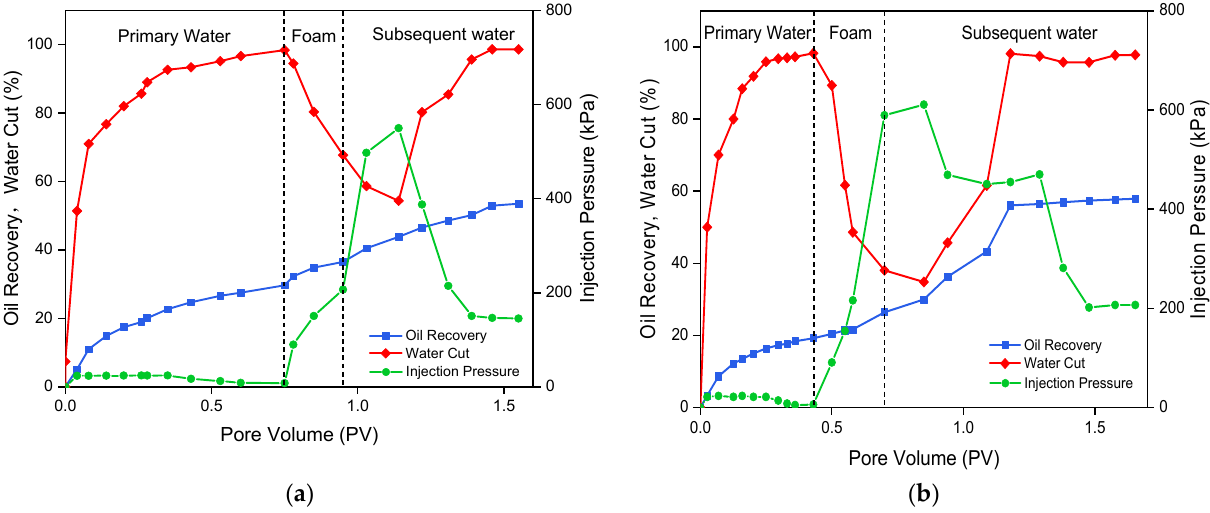
Figure 8. The influence of the three-phase foam slug size on oil displacement in parallel cores of permeability ratio 5: ( a ) 0.2 PV; ( b ) 0.3 PV.